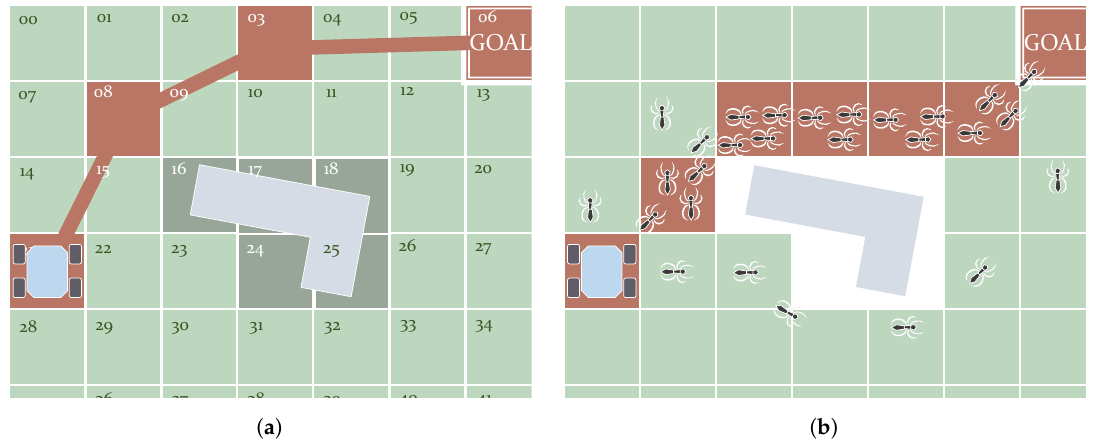
Figure 7. Examples of Evolutionary algorithms: Genetic ( a ) and Swarm Optimizer ACO ( b ). ( a ) Functioning of the genetic algorithms used to perform path planning. The path in this figure has the form of a chromosome with genes 21–08–03–06. ( b ) Functioning of the ACO algorithm. Simulated ants deposit more pheromones in the shortest path. Eventually the majority will follow this